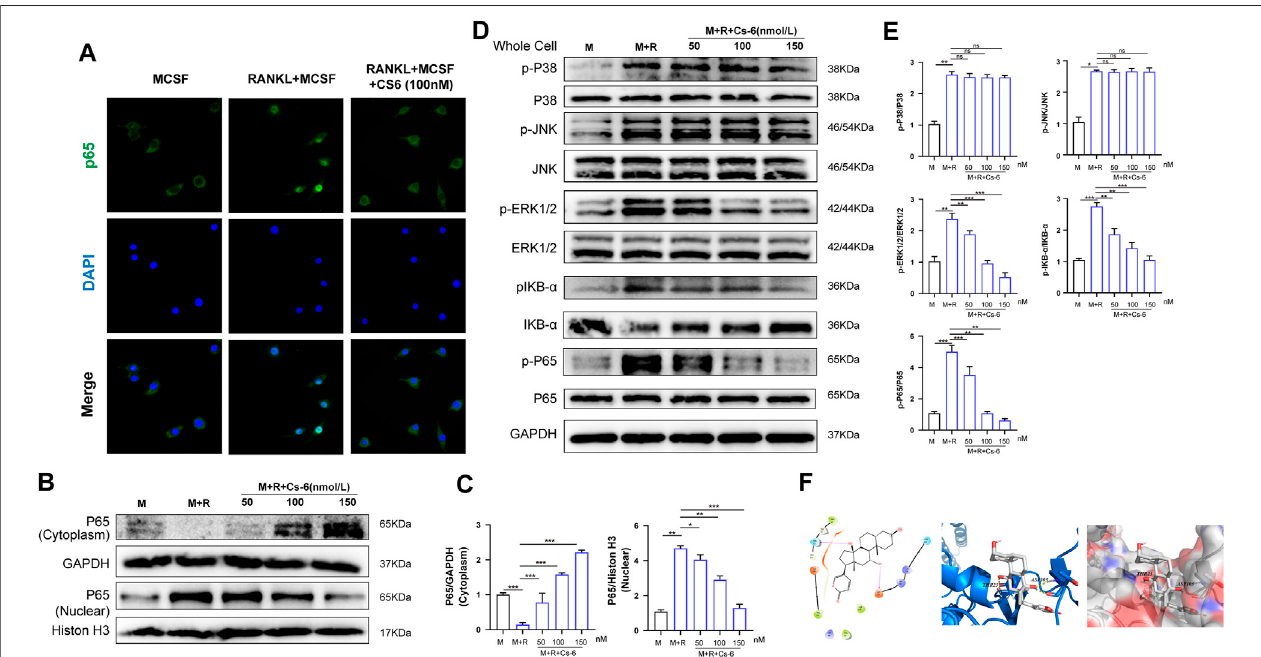
FIGURE5| CS-6attenuated RANKL-inducedactivationofNF- κ BandERK/MAPKsignaling pathways. (A) Representativeimmuno fl uorescenceimagesregarding the distribution of p65 in BMMs treated by RANKL (50 ng/ml) with or without CS-6 (100 nM) compared to the control group (30 ng/ml MCSF only). (B, C) The protein amount of p65 in cytoplasm and the nucleus was measured by Western blot and quanti fi ed, respectively. (D) BMM cells were pretreated with CS-6 (0, 50, 100, and 150 nM) for 3 h prior to stimulation with RANKL for additional 30 min. The total protein amount ofthe whole cell was determined by Western blot. The key proteins of NF- κ B and MAPK pathways were shown. (E) The expression of total proteins was quanti fi ed by graphs. (F) (Left) The predicted best binding manner of CS6 in the ATPbindingsite ofIKK β generatedwithdocking;hydrogen bondswereshown aspurplelines. (Middle) Co-crystalstructure oftheinteractionsbetweenCS6 andIKK β ; hydrogen bonds were displayed as red lines, and the participating amino acid residues (Thr23 and Asp103) were marked. (Right) MOLCAD representation of the molecular lipophilic potential surface upon the bioactive pose of CS6 in the ATP binding site of IKK β . The blue denoted the hydrophilic, red for the lipophilic, and gray denoted neutral moiety. Values were presented as the mean ± standard deviation ( n (cid:2) 3); * p < 0.05, ** p < 0.01, *** p < 0.001, **** p <